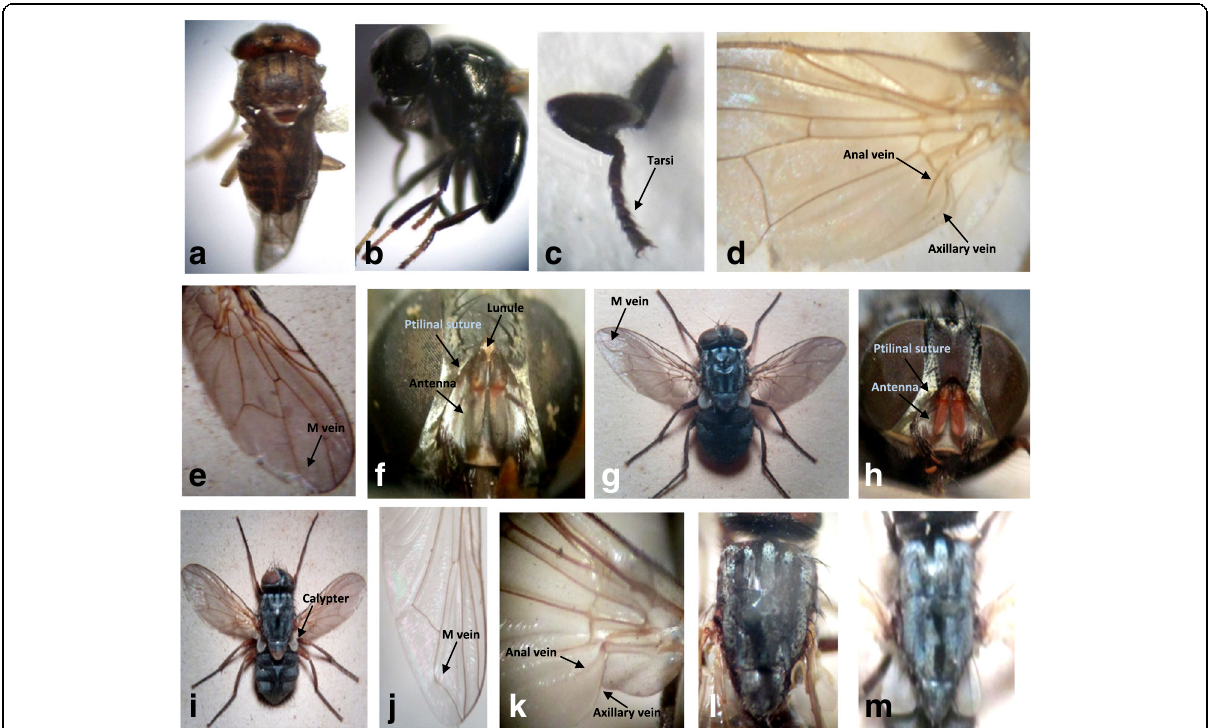
Fig. 2 a Drosophila repleta Wollaston, 1858, adult; b, c Chlorichaeta albipennis (Loew, 1848), b adult lateral view, c fore leg; d Fannia sp. fore wing; e, f, i Muscina stabulans (Fallén, 1817), e fore wing, f head frontal view, i adult; g, h Synthesiomyia nudiseta (Van Der Wulp, 1883), g adult, h head frontal view; j – l Musca domestica (Linnaeus, 1758), j, k fore wing, l thorax dorsal view; m Musca sorbens (Wiedemann, 1830),